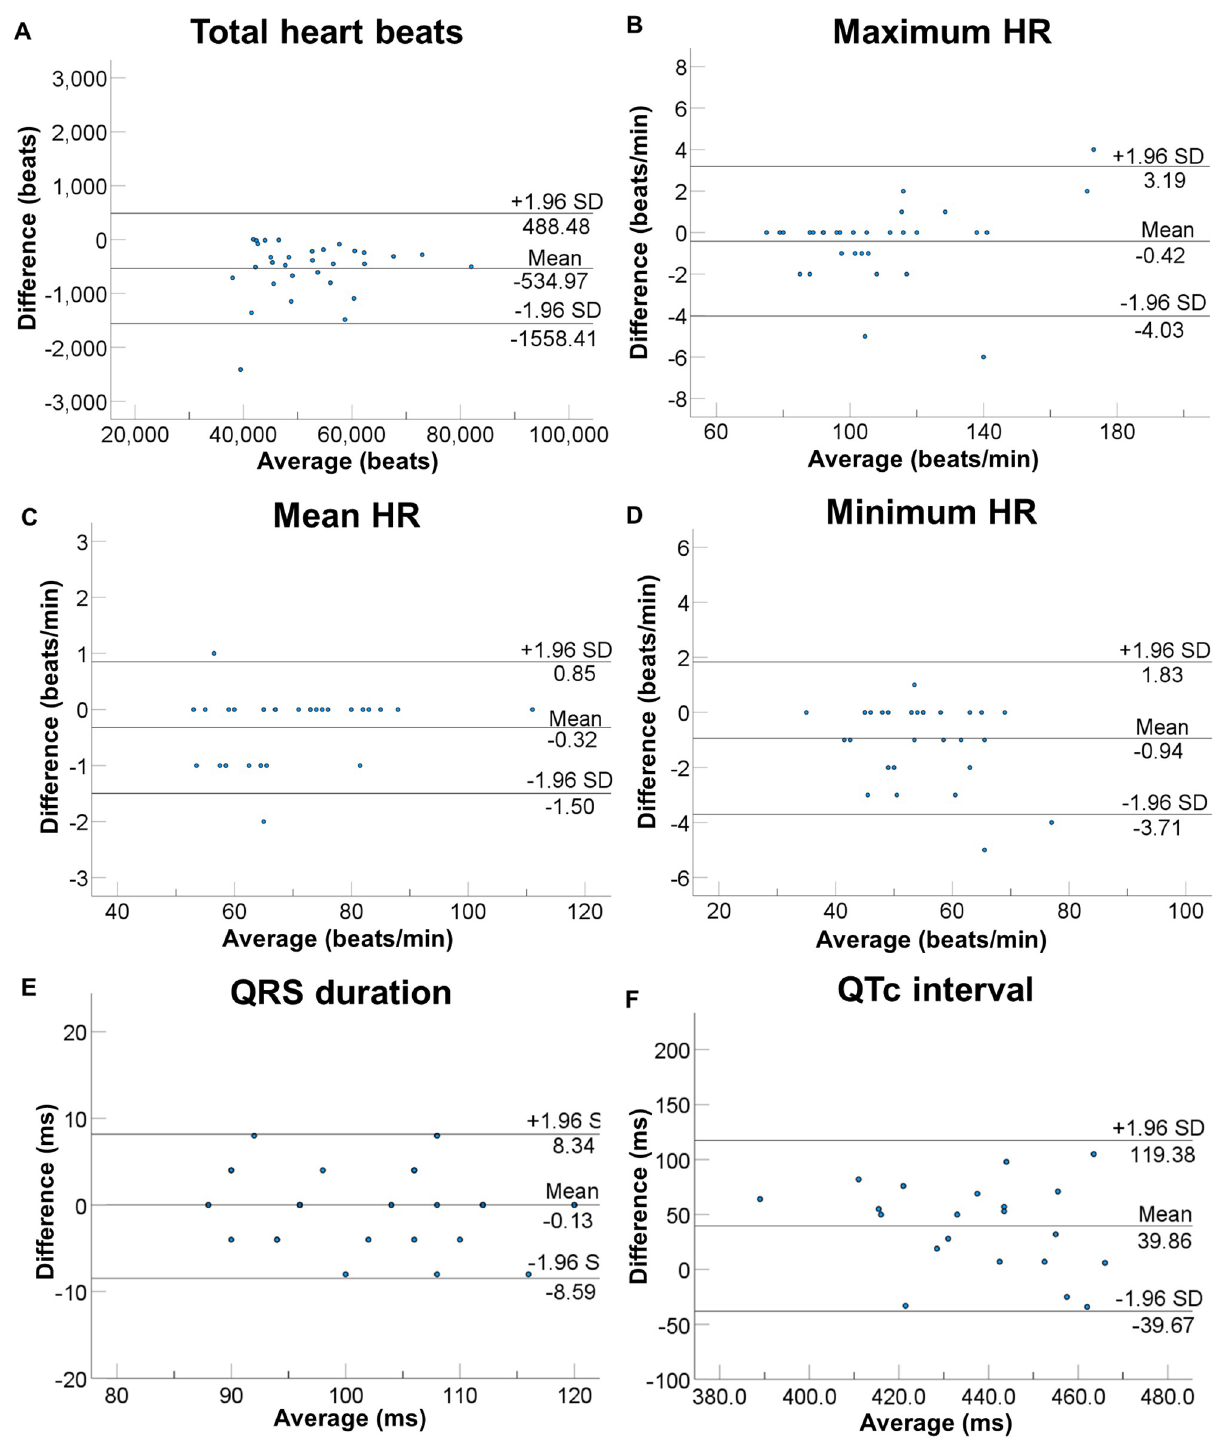
Fig 3. Bland-Altman plots of each parameter measured by wearable electrodes embedded in undershirts and Holter ECG. (A) Bland-Altman plots of total heart beats, (B) maximum HR, (C) mean HR, (D) minimum HR, (E) QRS duration and (F) QTc interval measured by two methods. Abbreviations: HR, heart